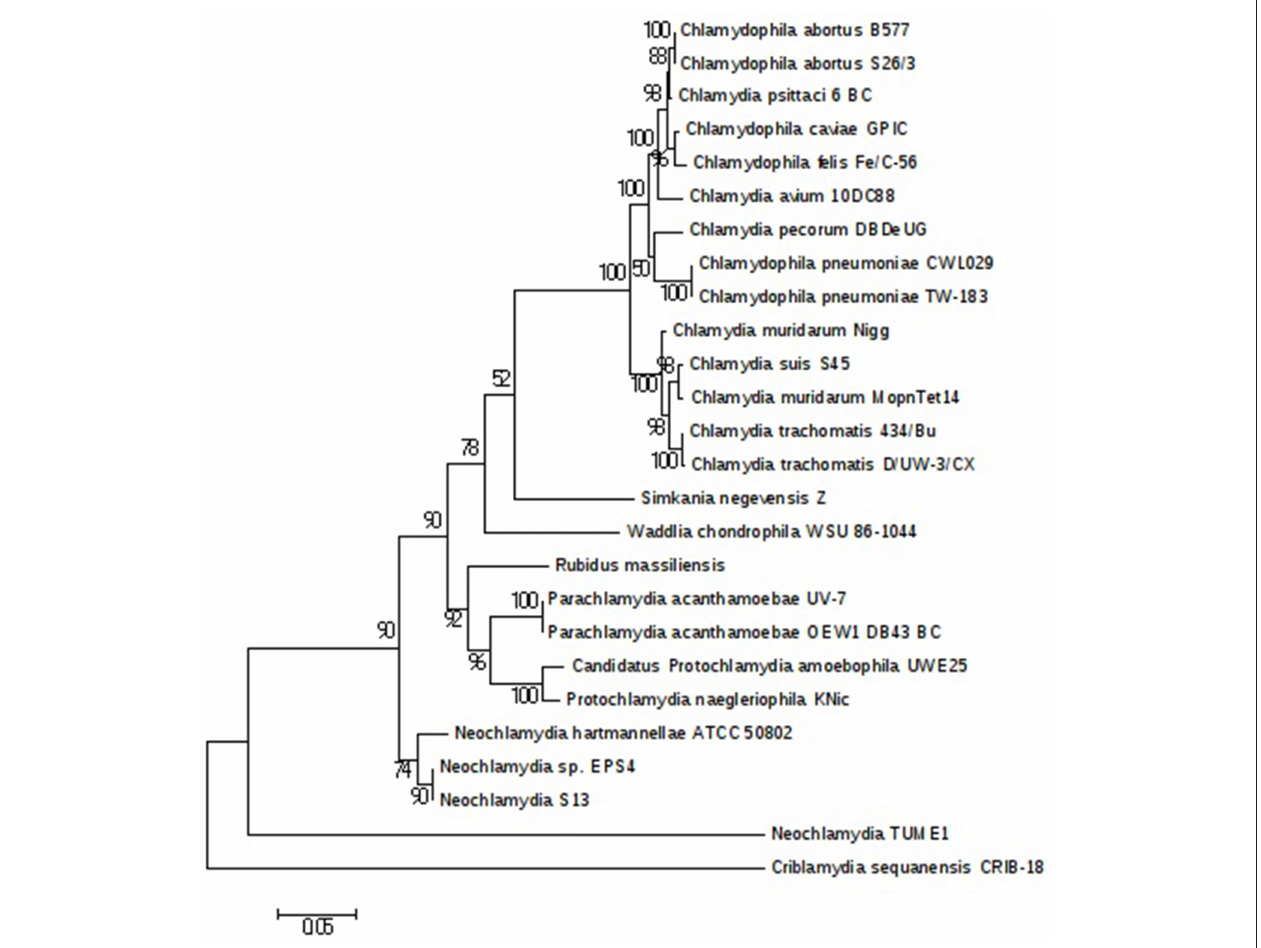
FIGURE 4 | Chlamydiales members clustering according to a phylogenetic tree analysis. Maximum-likelihood (PhyML) phylogenetic tree calculated with JTT + G substitution model With the RNA 16S sequences of 26 Chlamydiales members . Bootstrap Proportion values are indicates at the